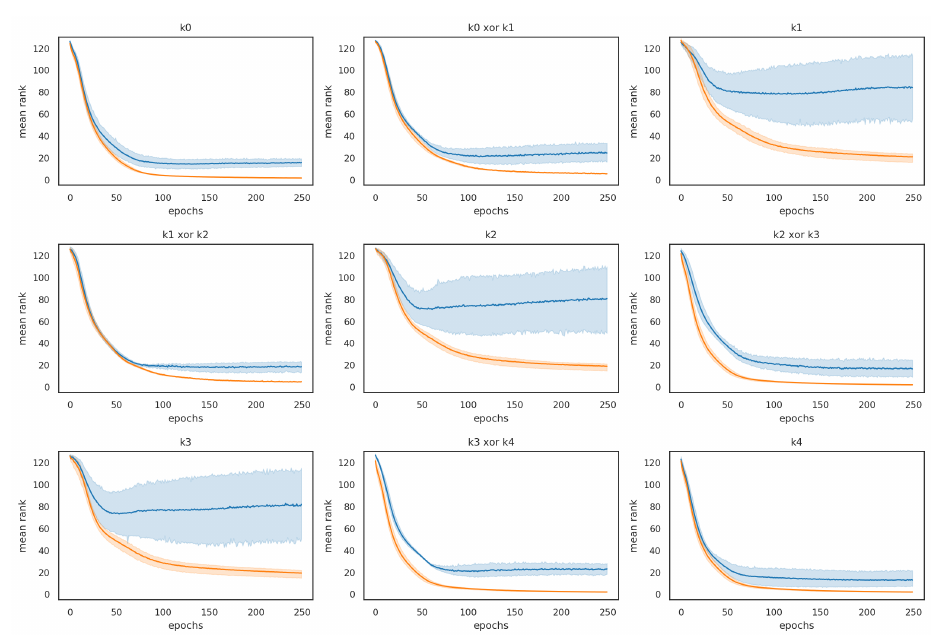
Figure 8: Average validation (orange) and attack rank (blue) versus the number of epochs for each of the labels over the 6-fold cross-validation indicated by the error